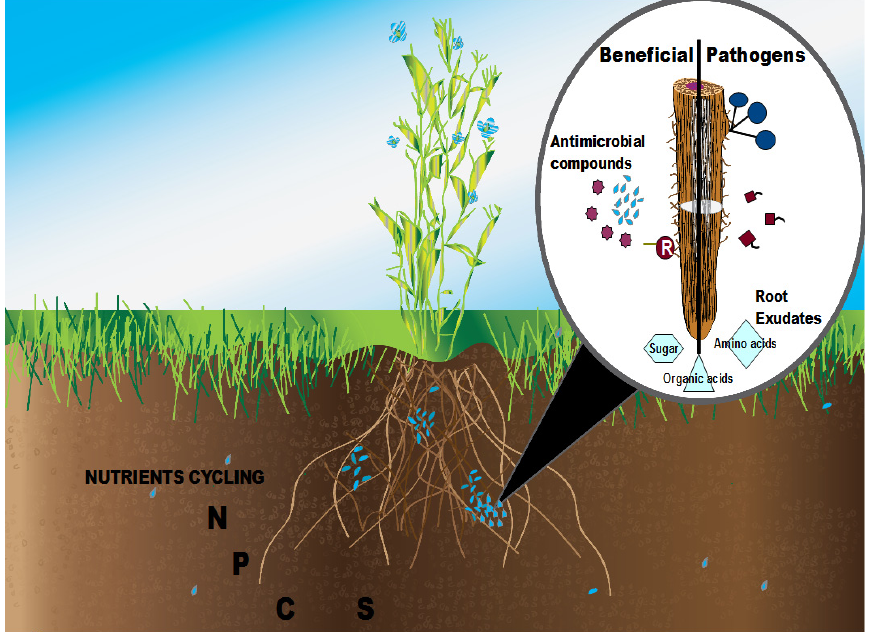
Figure 1. Examples of plant-microbe interactions in the rhizosphere. Plant roots release exudates containing sugars, organic acids, and amino acids that may attract